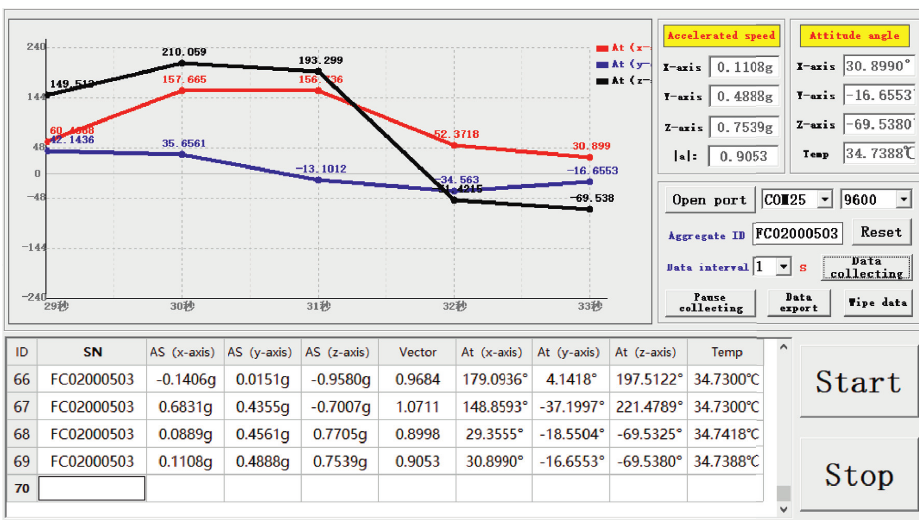
Figure 4: The data acquisition and analysis software of ISA.